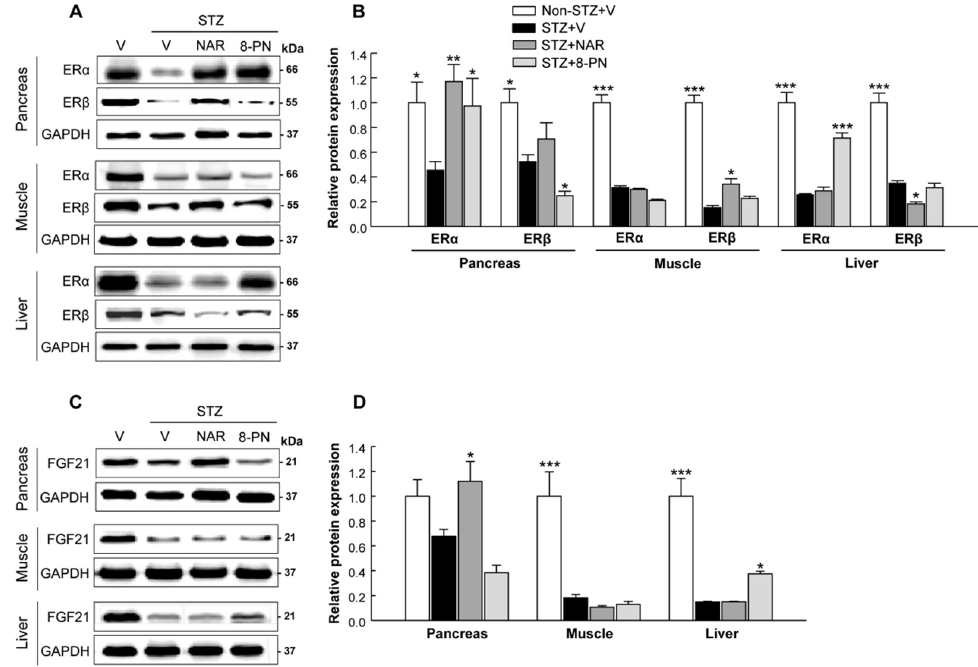
Figure 6. Effects of naringenin and 8-PN on protein expressions of estrogen receptors and FGF21 in target tissues. ( A ) Representative Western blot images of estrogen receptor- α and - β in the pancreas, skeletal muscle, and liver and ( B ) corresponding quantitative data. ( C ) Representative Western blot images of fibroblast growth factor 21 in the pancreas, skeletal muscle, and liver and ( D ) corresponding quantitative data. V, vehicle; NAR, naringenin; 8-PN, 8-prenylnaringenin. Data are shown as means ± SEM (n = 6). * p < 0.05, ** p < 0.01, *** p < 0.001 vs. STZ-vehicle group.